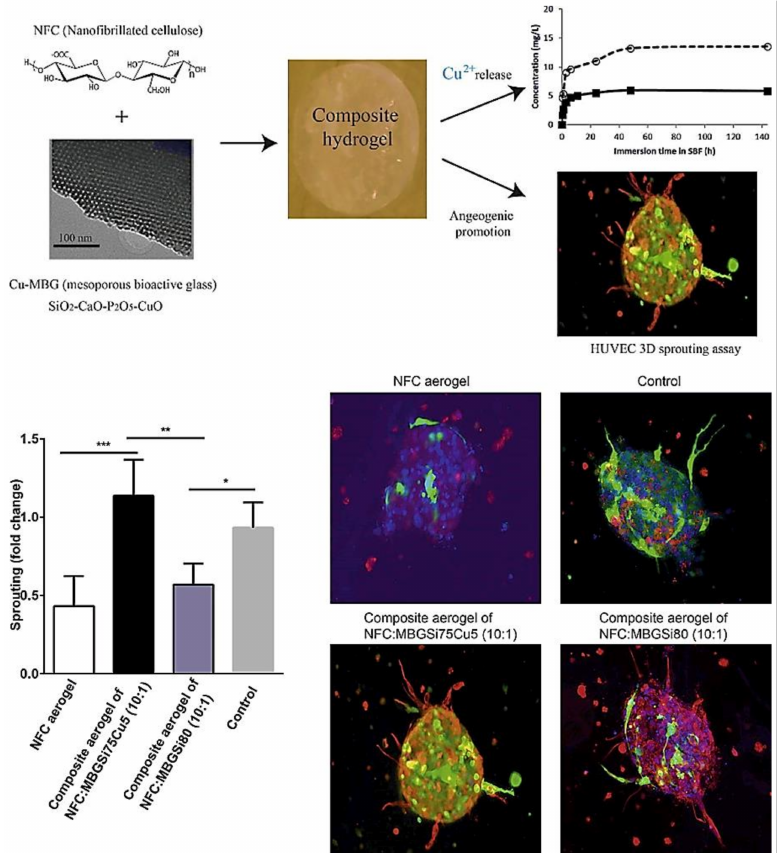
Figure 6. Sprouting of HUVEC spheroids with NFC, NFC: MBGSi80 (10:1) and NFC: MBGSi75Cu5 (10:1) composite aerogels: representative confocal images of expression of vimentin (in red) and fibronectin (in green) in HUVEC spheroids. The cell nuclei are counterstained with DAPI (blue). Bar = mean of sprout numbers ± s.e.m., n = 4. *— p < 0.1; **— p < 0.01; ***— p < 0.001. With permission from [138]. Copyright 2016